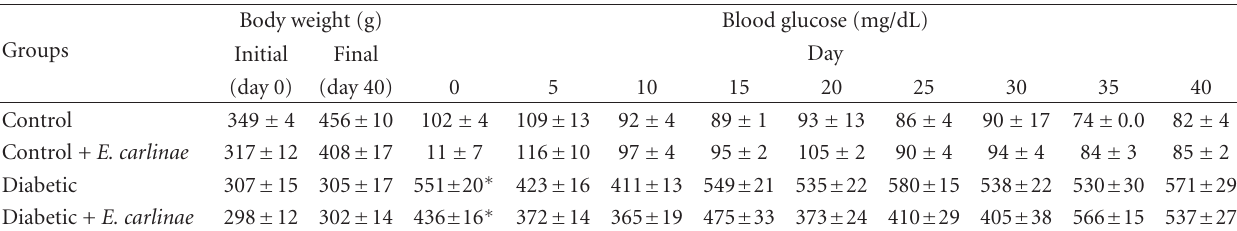
Table 1: E ff ect of E. carlinae on body weight and blood glucose.